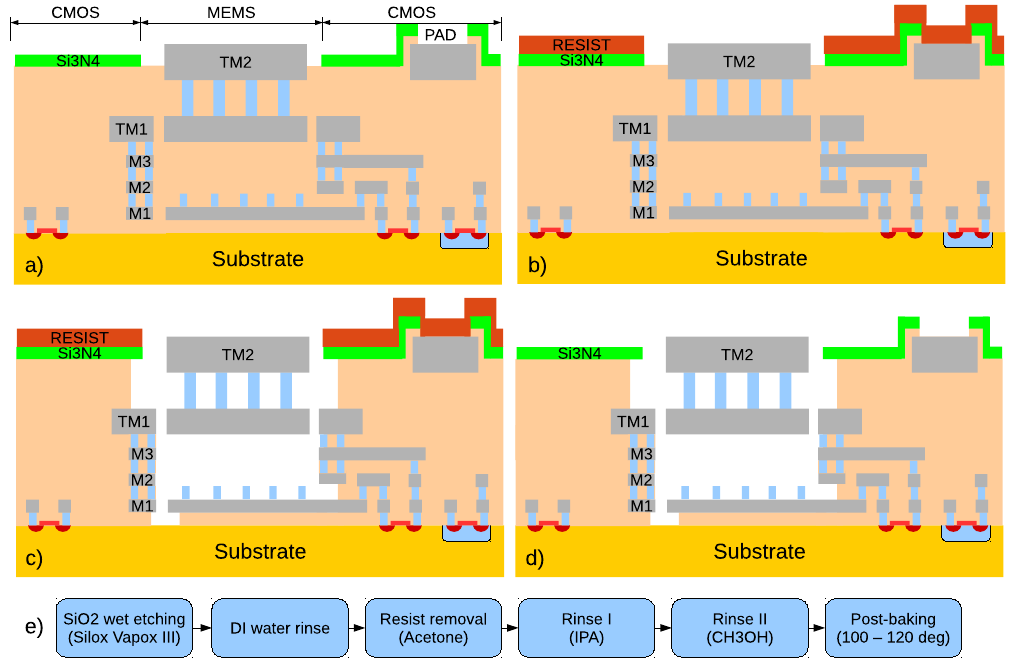
Figure 2. Simplified cross-sections illustrating the post-processing steps: after standard CMOS processing finished with the passivation opening ( a ); after the photo-resist deposition to protect the pads and passivation ( b ); after the SiO2 wet etching ( c ) ;and after the resist removal, rinsing and post-baking ( d ). The diagram ( e ) enumerates the steps used in the in-house release